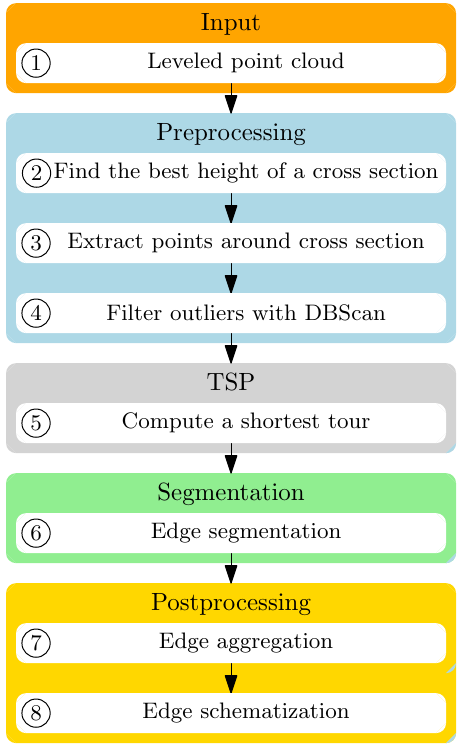
Figure 1: Summary of the processing pipeline of our ap-proach which automatically extracts a 2D footprint from a 3D point